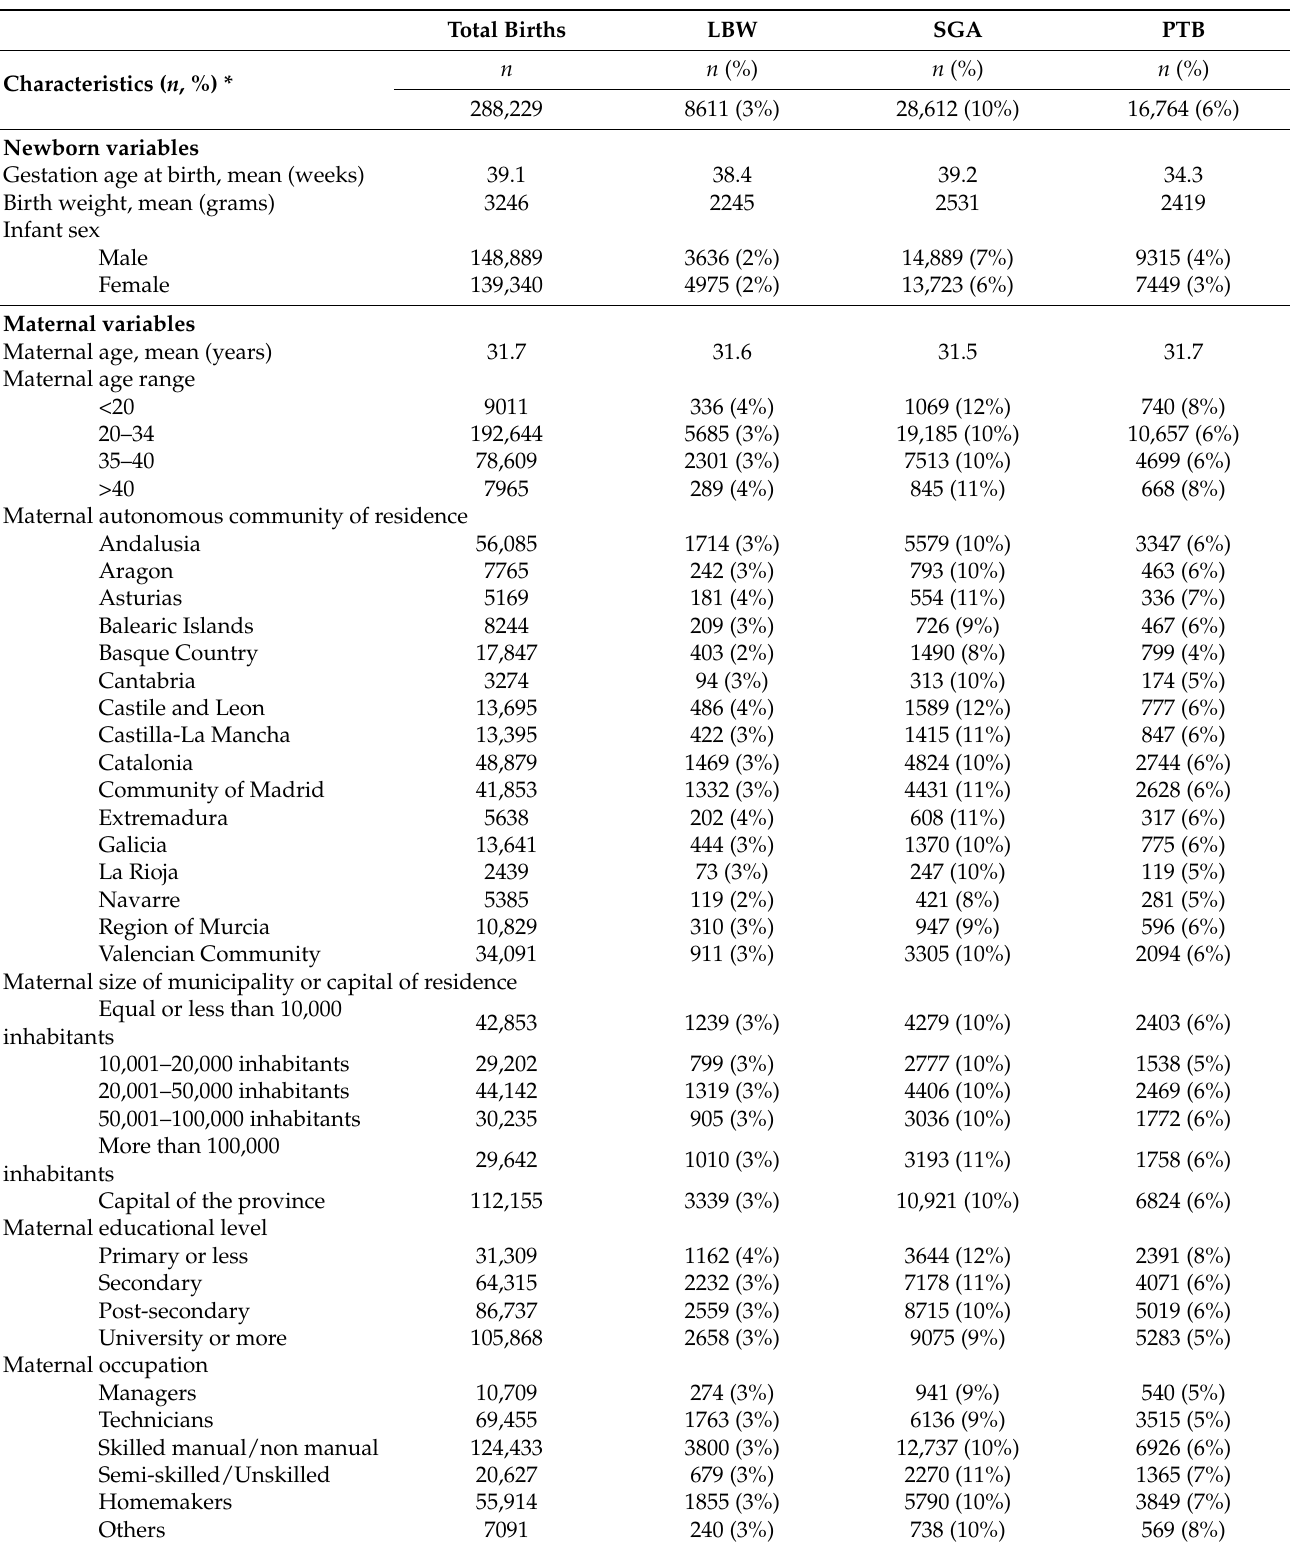
Table 1. Birth outcomes by gestational, maternal, paternal and newborn characteristics,